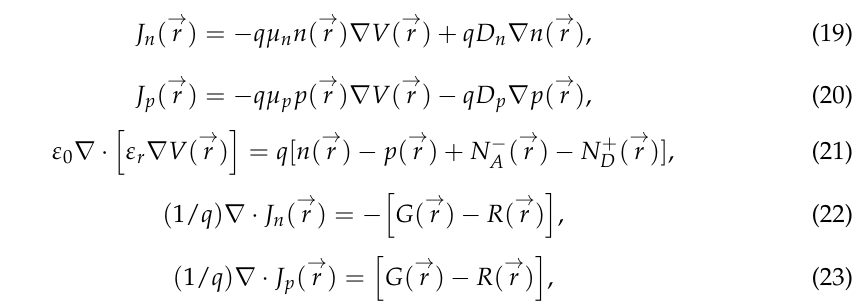
→ r ) and D represent electron n ( p ) n ( p ) → → → r ) , p ( r ) , and V ( r ) → → ( ( r ) , and N + r ) are D A